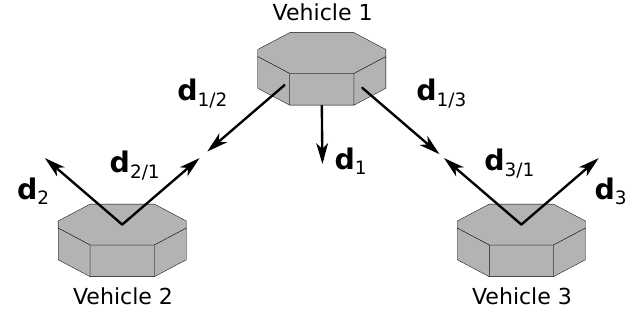
Figure 1. Three-vehicle heterogeneous